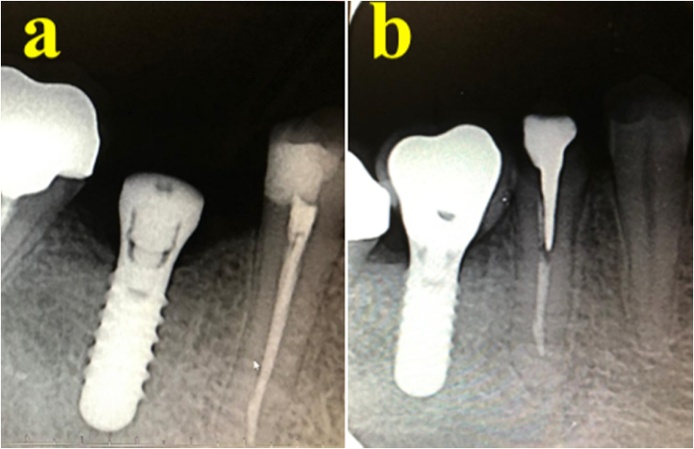
(A) Single implant inserted to replace molar tooth. (B) 12 months after loading of the implant.